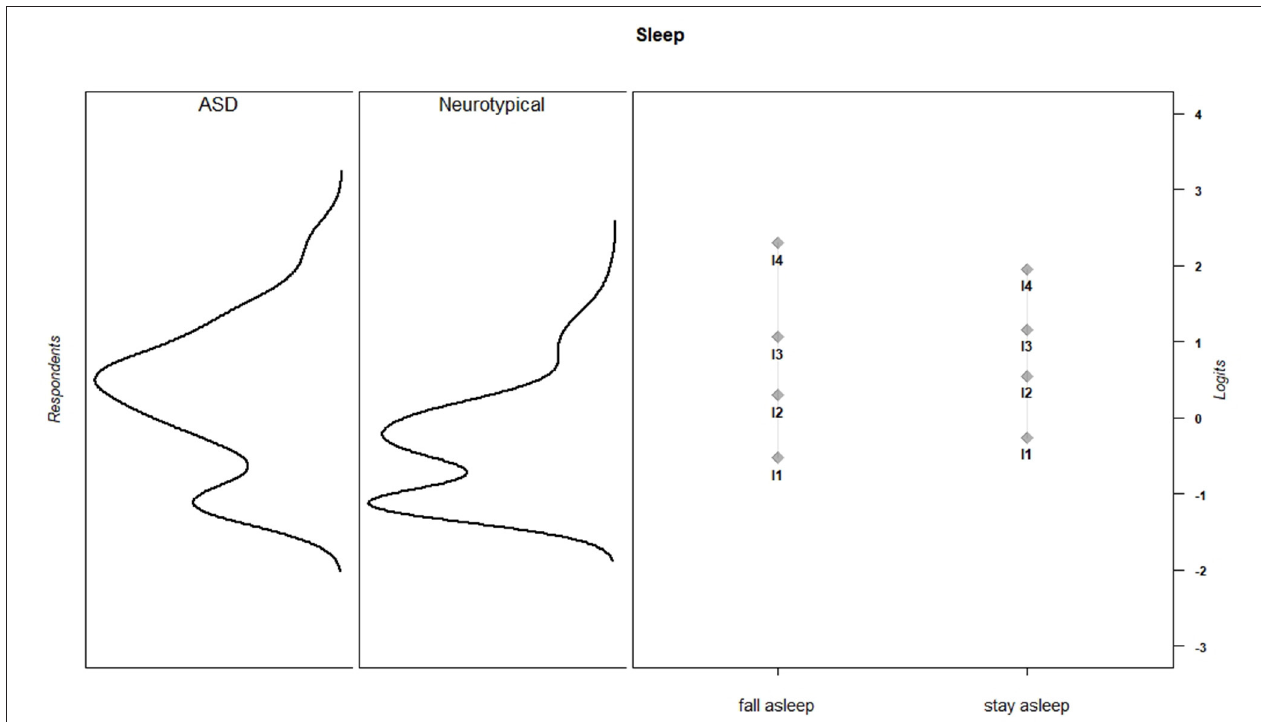
FIGURE 4 | Sleep item parameters and person parameters by